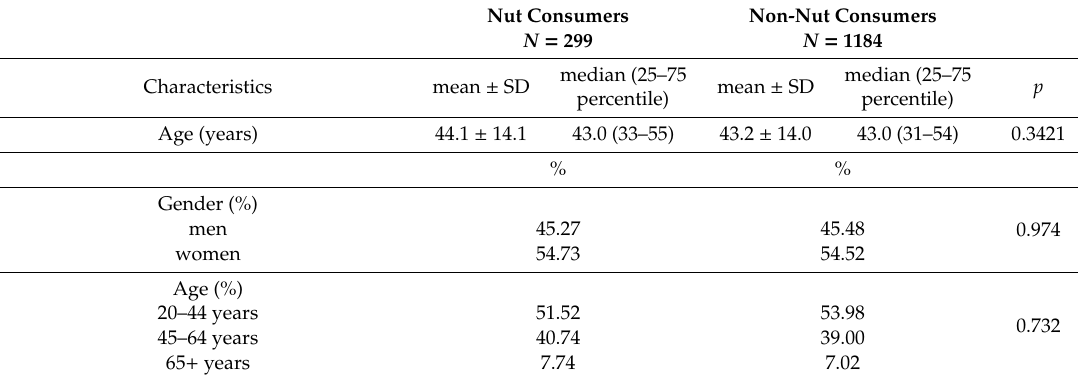
Table 1. Descriptive statistics of the studied